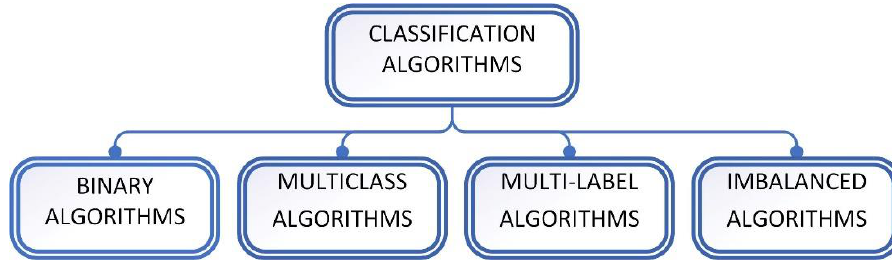
Figure 4. Classification algorithms.